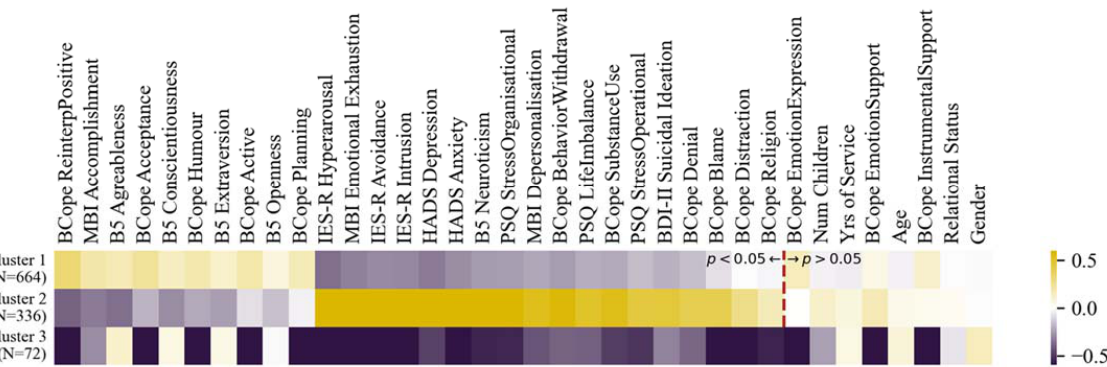
Figure 3. Hierarchical clustering analysis: Mean values of each variable (after Yeo ‐ Johnson transfor ‐ mation and standardization) for each cluster. Variables are sorted based on the most significant positive differences between cluster 1 and 2, most significant negative differences, then non ‐ signif ‐ icant differences. All pairwise significance tests between the clusters are provided in Table S2 in the Supplementary Materials. Note : Bcope = The Coping Orientation to Problems Experienced Inven ‐ tory, B5 = Big Five Inventory in French, IES ‐ R = Impact of Event Scale–Revised, MBI = Maslach Burnout Inventory, HADS = Hospital Anxiety and Depression Scale, BDI ‐ II = Beck Depression In ‐ ventory, PSQ = Police Stress Questionnaire; see Section 2 for a detailed explanation.